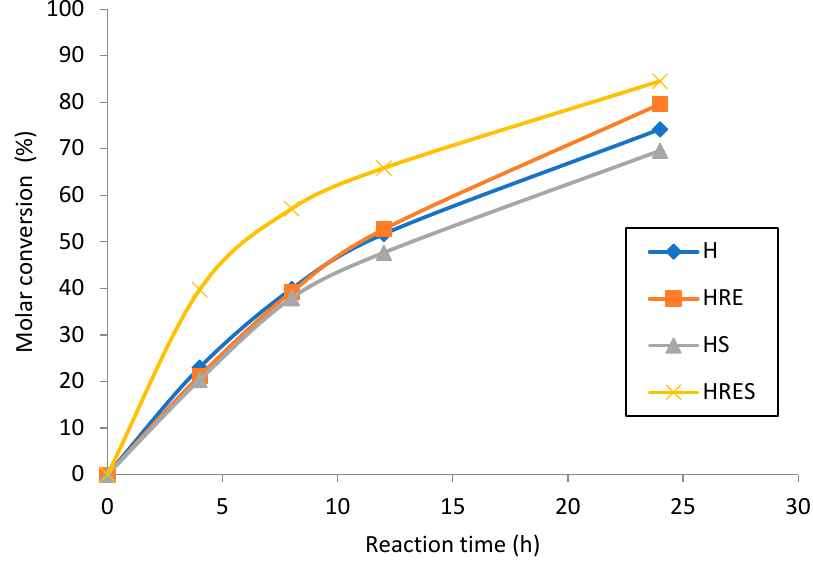
Figure 2. Effect of equipment on the molar conversion of octyl cinnamate. H: rotary evaporator without vacuum; HRE: rotary evaporator with vacuum; HS: ultrasonic bath; and HRES: rotary evaporator with vacuum and ultrasonic bath. The ultrasonic bath was operated at 150 W.